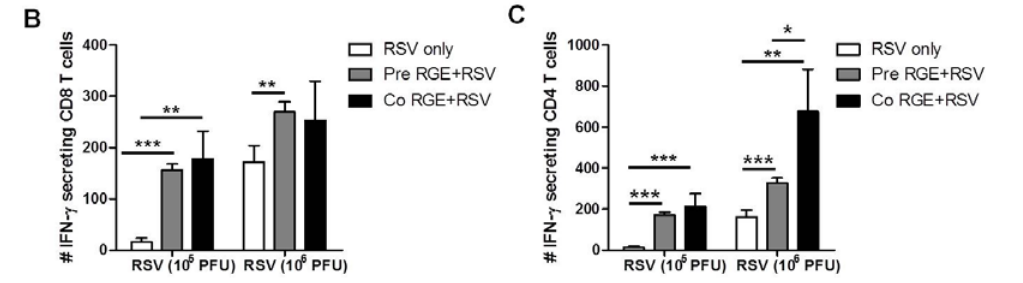
Figure 7. Phenotypes of interferon (IFN)-γ secreting T cells in bronchoalveolar lavage fluids (BALF) from mice with RGE treatment and respiratory syncytial virus (RSV) infection. BAL cells were harvested, stained with CD45, CD3, CD8α, CD11b, CD11c, and IFN-γ antibodies, and analyzed by flow cytometry. IFN-γ secreting T cells were presented as total numbers per mouse. ( A ) Flow cytometry of RSV F peptide specific CD8 + IFN-γ + T cells and RSV G peptide specific CD8 + IFN-γ + T cells. Numbers in dot plots indicate the cell percentages of double positive population; ( B ) Numbers of RSV F peptide specific CD8 + IFN-γ + T cells; ( C ) Numbers of RSV G peptide specific CD8 + IFN-γ + T cells. Values are the mean ± SEM. * p < 0.05; ** p < 0.01; *** p < 0.001. RSV only: naïve mice infected with RSV in PBS, Pre red ginseng extract (RGE) + RSV: naïve mice were pretreated once intranasally with RGE (4 mg per mouse) 24 h prior to infection with RSV, Co RGE + RSV: naive mice were treated once intranasally with the mixture of RGE (4 mg per mouse) and